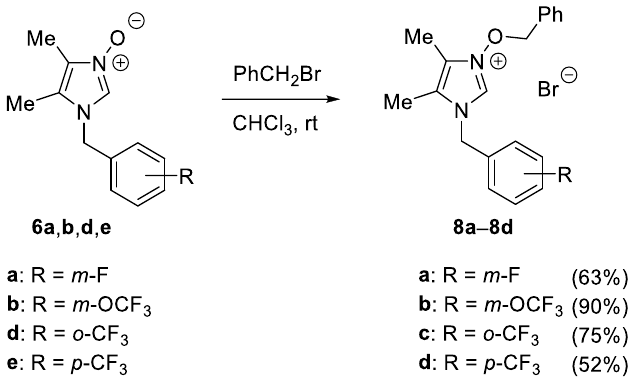
Scheme 2. O -Benzylation reactions of imidazole N -oxides 6a , b , d , and e with benzyl bromide leading to alkoxyimidazolium salts 8a – 8d .